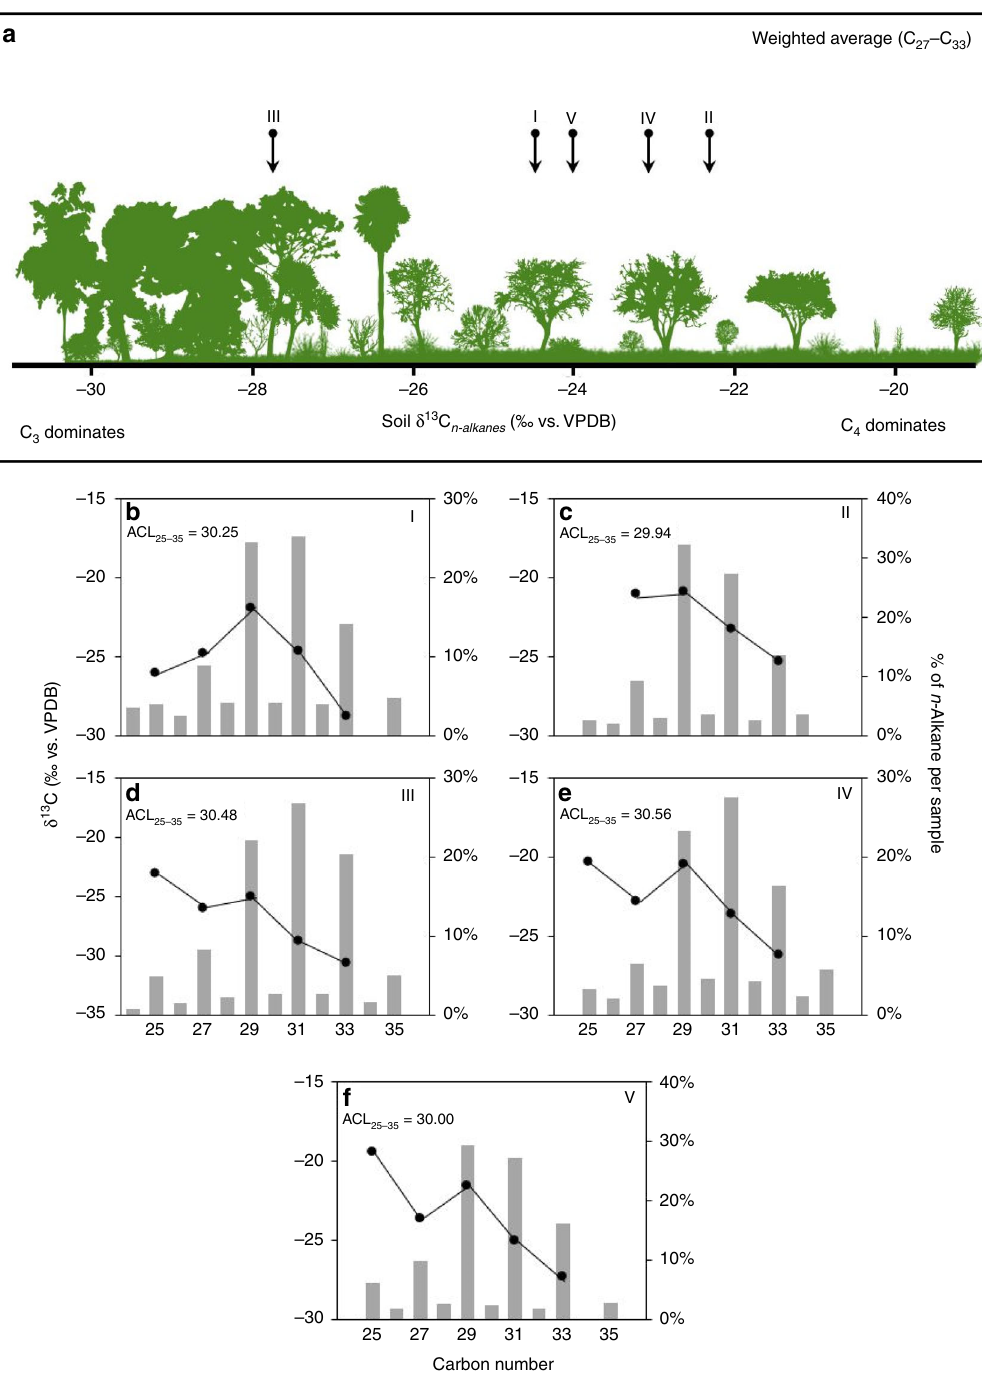
Fig. 7 Plant wax biomarkers. a Plant landscape reconstruction using δ 13 C of the weighted mean average of the C 27 – C 33 n -alkanes. A sine-squared mixing model with end-member values of − 30 ‰ (for pure C 3 ) and − 19 ‰ (for pure C 4 ) was used to visualize plant ecology during sample deposition. The δ 13 C of n -alkanes vary between − 29 ‰ and − 39 ‰ in extant C − 14 ‰ and − 26 ‰ in C – f Graphs 3 plants and 4 vegetation. VPDB Vienna Pee-Dee Belemnite. b show relative abundance of each n -alkane compound (grey bars), their δ 13 C values (black circles), and average chain length (ACL) of C 25 – C 35 carbon homologue. Roman numerals indicate provenance in the stratigraphic column from bottom to top, and these are individual samples, not composite. The placement of each sample along the soil/plant gradient is based on the obtained weighted average for each